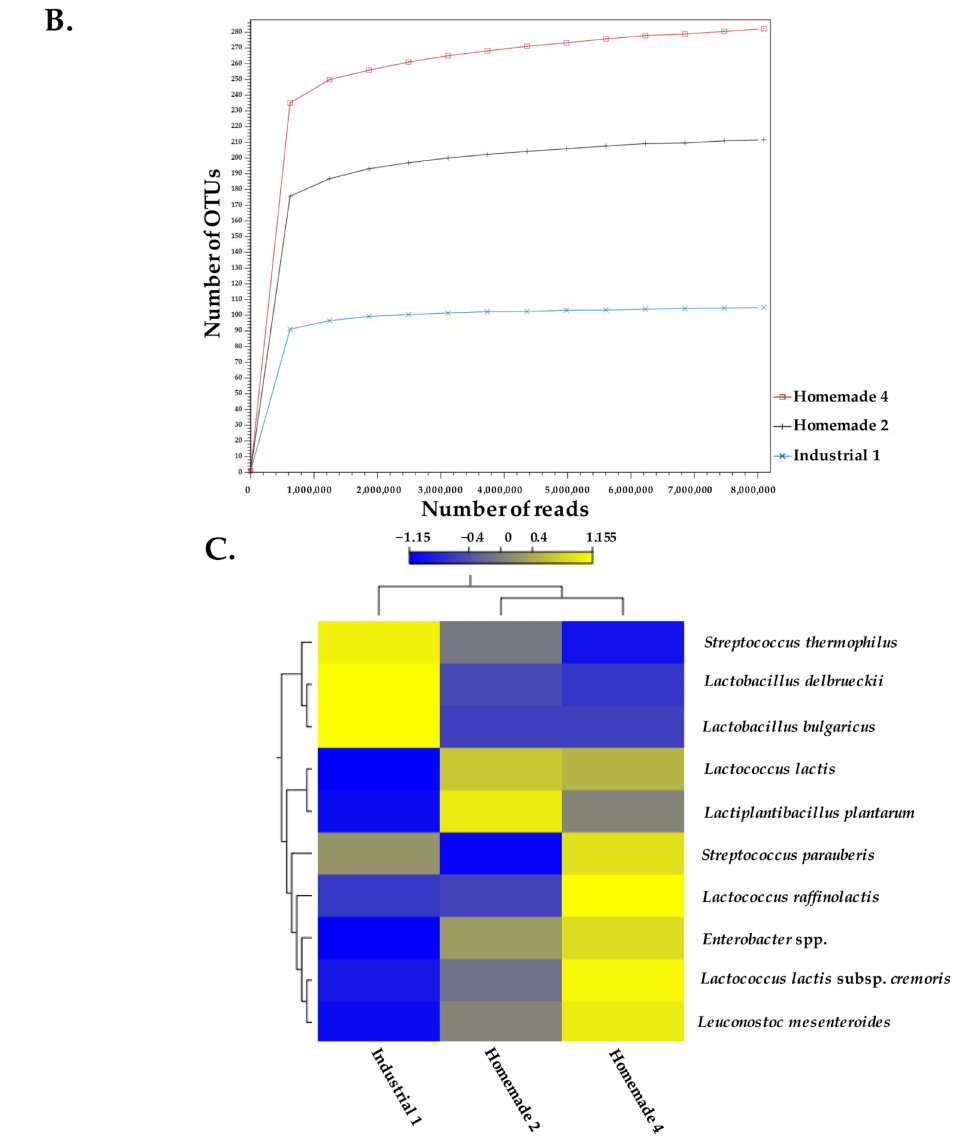
Figure 5. Taxonomic profile of Industrial sample 1 and Homemade samples 2 and 4 of Feta cheese, based on the mapping of shotgun metagenomics reads against a representative genome dataset deriving from GenBank and RefSeq. Taxa were clustered at the species level ( A ). Alpha-diversity of shotgun reads measured using the total number of OTUs of industrial and homemade Feta cheese samples. In the graph, 8M reads are shown ( B ). Heat map analysis of the 10 most abundant species/subspecies present in at least two samples ( C